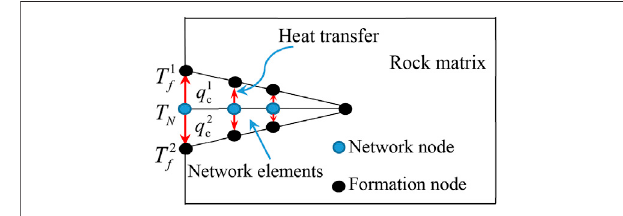
FIGURE 1 | Heat transfer between fi nite element nodes in the formation and